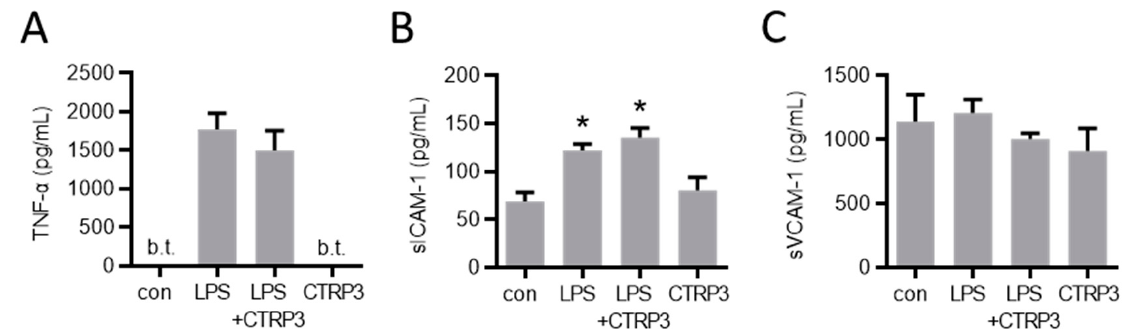
Figure 6. LPS-induced systemic markers of endothelial inflammation are not affected by CTRP3 in vivo. Male C57BL/6J wild-type mice were treated with i.p. injection of recombinant CTRP3 (C1q/TNF-related protein 3, 10 µg/animal) 30 min prior to i.p. LPS-injection (lipopolysaccharides, 1 µg/animal) for 2 h. LPS and CTRP3 alone were used as controls. ( A ) TNF- α (tumor necrosis factor- α ), ( B ) sICAM-1 (soluble intercellular adhesion molecule-1) and ( C ) sVCAM-1 (soluble vascular cell adhesion molecule-1) protein levels in blood serum were quantified by ELISA. * p < 0.05 con = unstimulated control, n = 3–9.